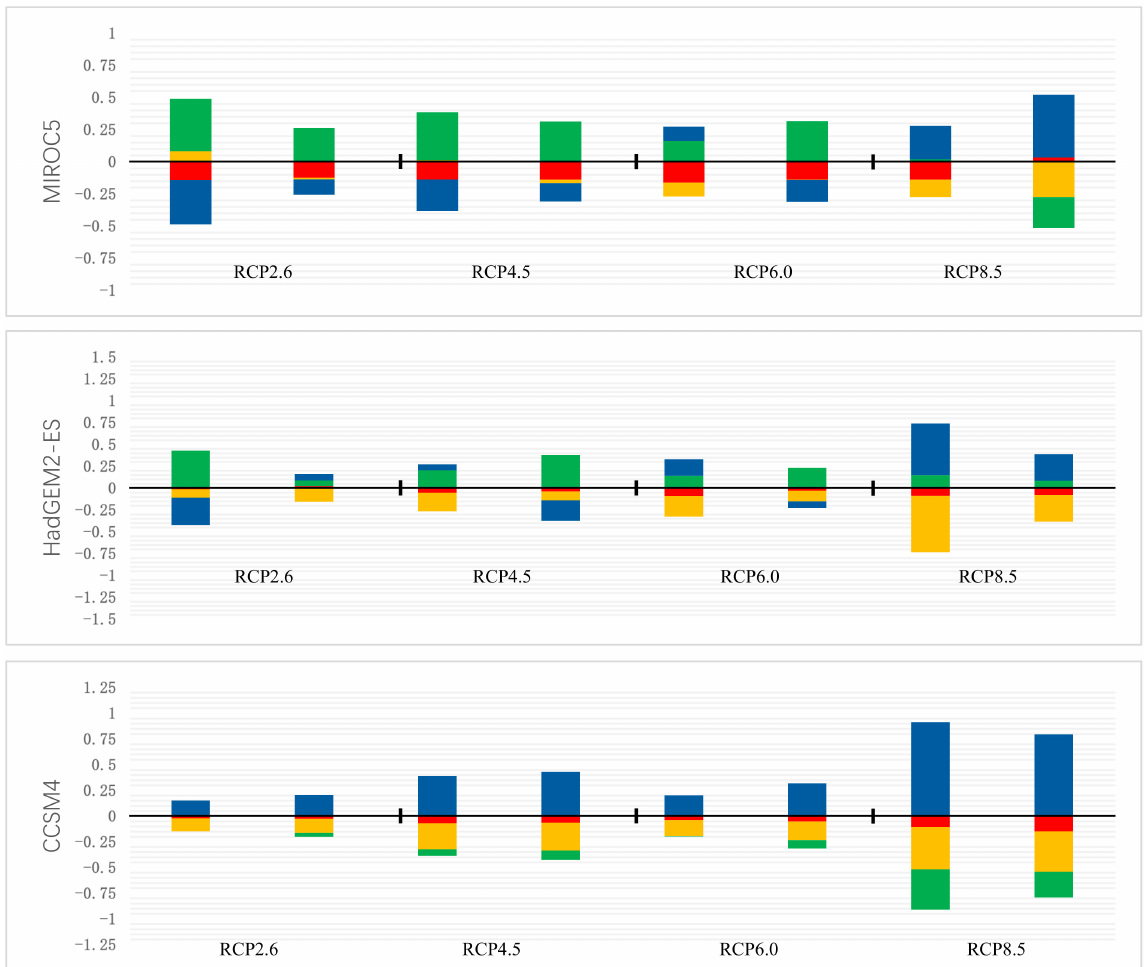
Figure 5. Four different levels of fluctuation in China’s future climate scenarios: Green, orange, red and blue represent the proportion of high, medium and low suitability areas and unsuitable habitats, respectively. A positive value indicates an increase in area and a negative value indicates a decrease in